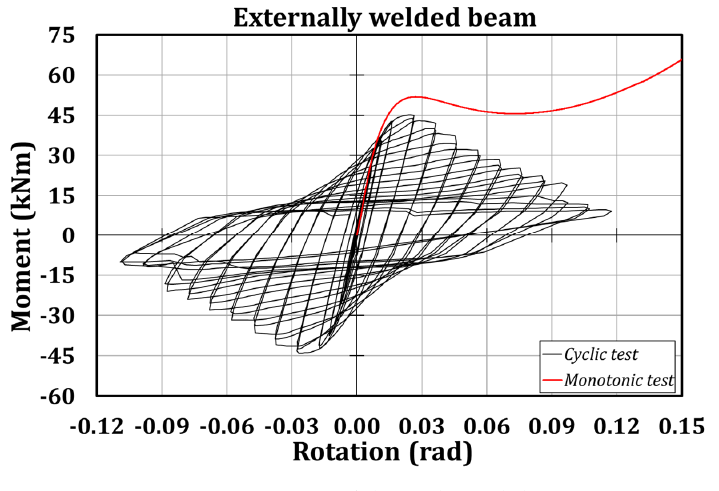
Figure 6. Tested specimens subjected to cyclic and monotonic loading